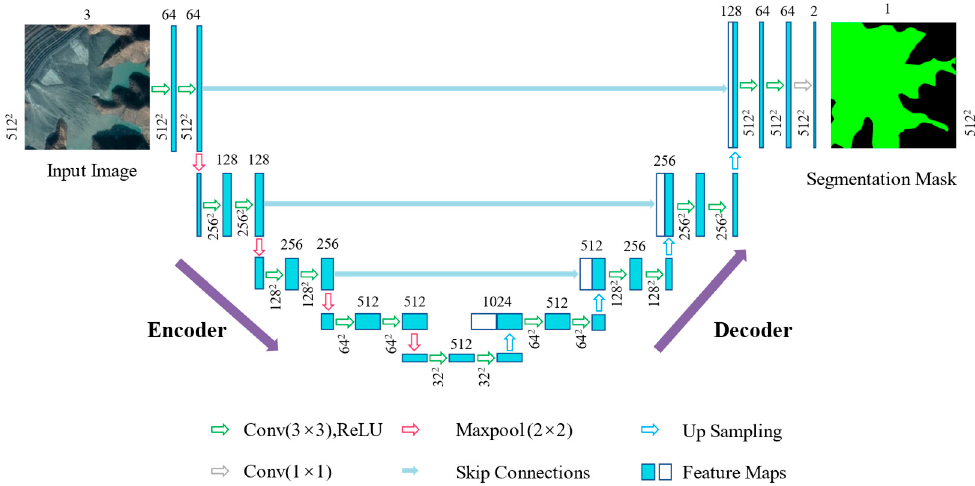
Figure 4. Network structure of the U-Net model. The encoder is located on the left side of the U-shape, and the decoder is located on the right side.